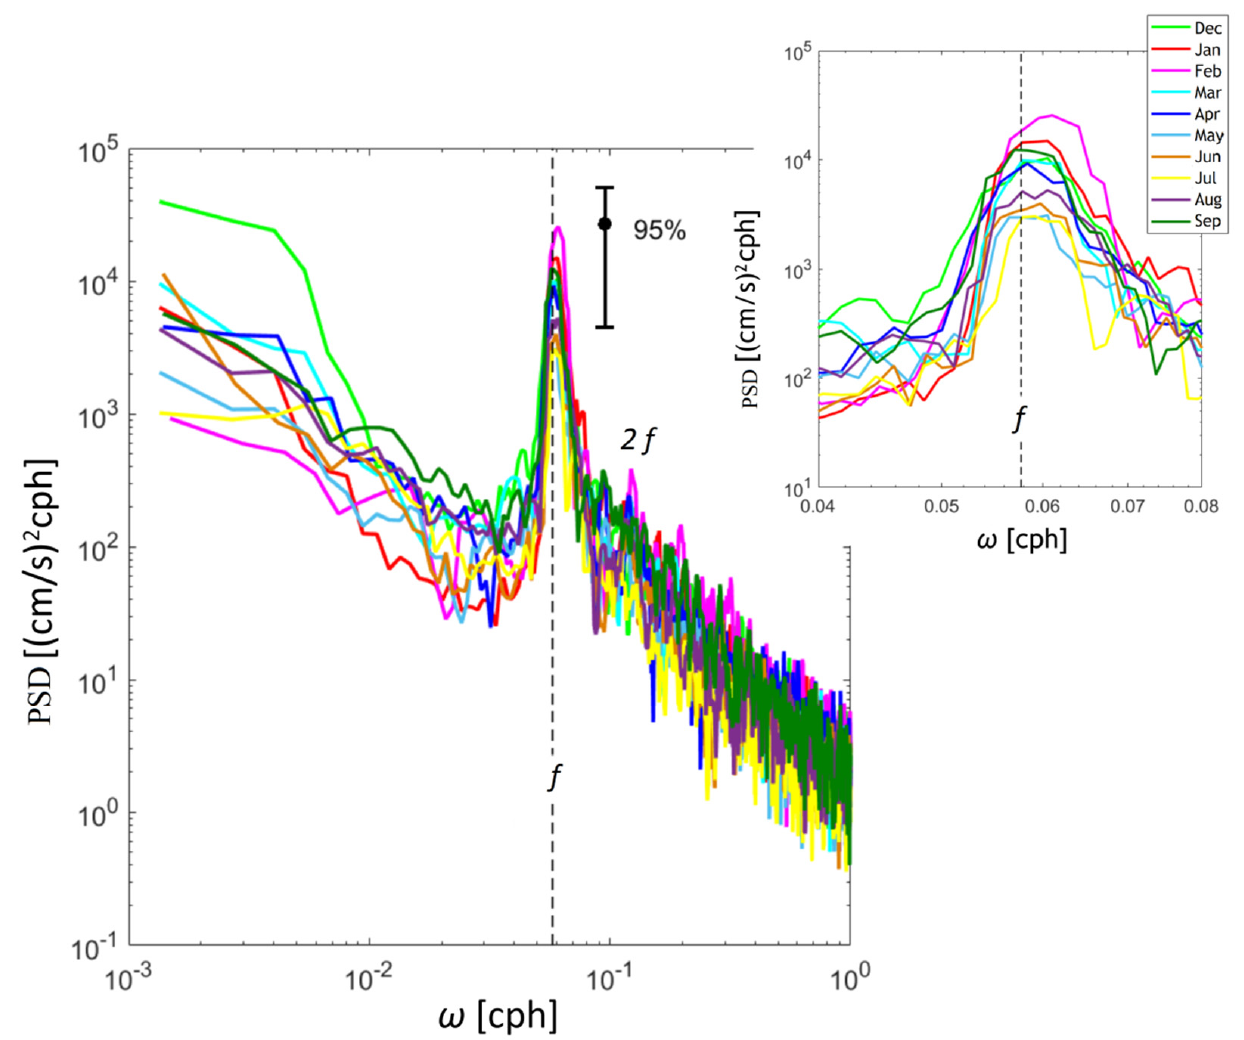
Figure 6. The rotary spectra of clockwise rotation motion at 100 m at ABS No. 1 in different months. The dashed line indicates the local inertial frequency in the study area. The small image in the upper right corner is an enlargement of the figure to better visualize the peaks close to the inertial periods.